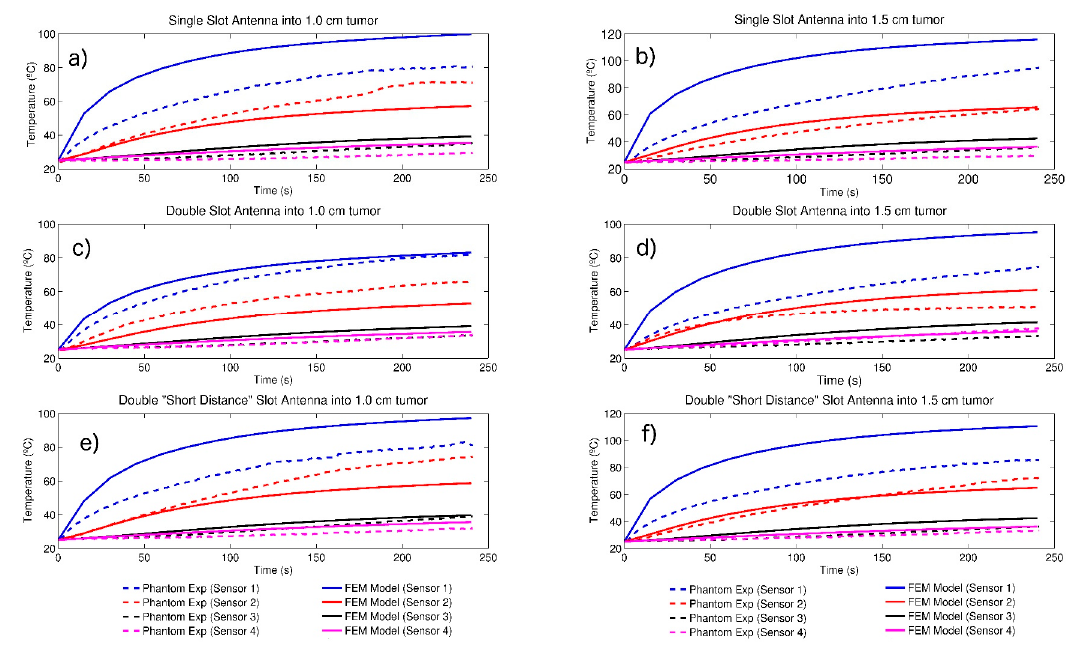
Figure 4. Temperature distribution comparison in tumor tissue surrounded by breast tissue obtained from Phantom Experimentation and the FEM Model. Temperature comparison in thermal sensors were located alongside the slot antenna, the solid lines represent the FEM model results, while the dotted lines represents the experimental results during 240 s at 10 W of power. ( a ) Single slot antenna inside the 1.0 cm diameter tumor, ( b ) Single slot antenna inside the 1.5 cm-diameter tumor, ( c ) Double slot antenna inside the 1.0 cm diameter tumor, ( d ) Double slot antenna inside the 1.5 cm diameter tumor, ( e ) Double “short distance” slot antenna inside the 1.0 cm diameter tumor and ( f ) Double “short distance” slot antenna inside the 1.5 cm diameter tumor.